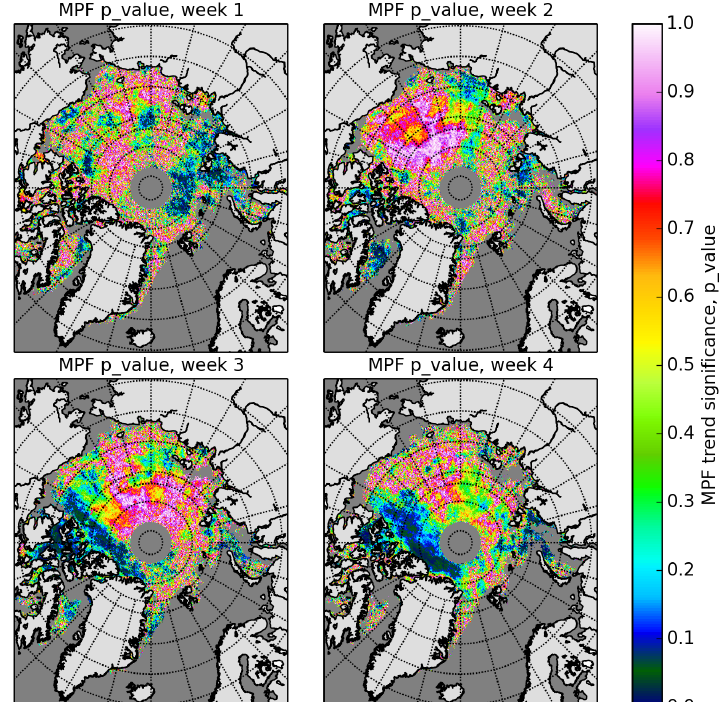
Figure 8. P values for the weekly MPF trends (see Fig.